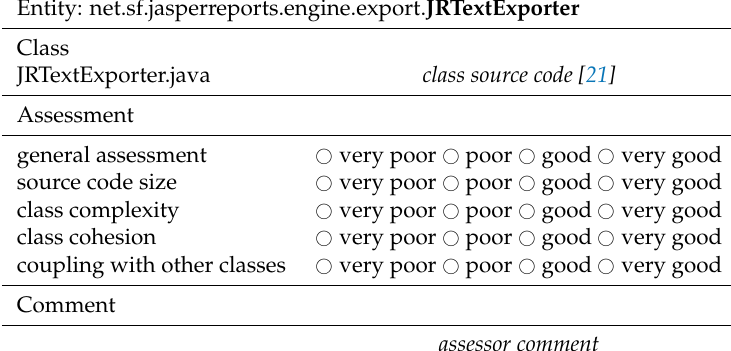
Table 1. A program entity evaluation